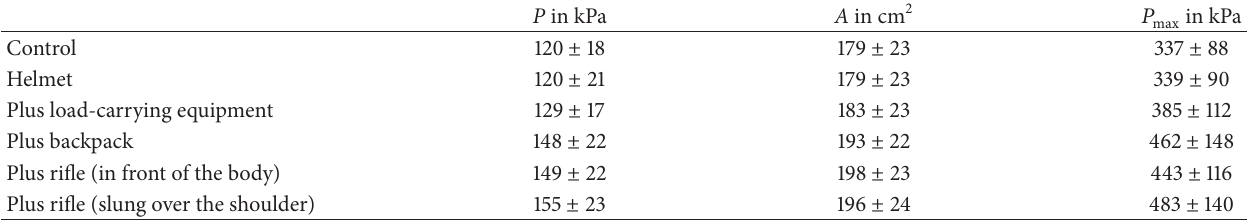
Table 6: Dynamic measurement results for contact area ( A ), pressure ( P ), and maximum pressure ( 𝑃 max ) during midstance. P in kPa